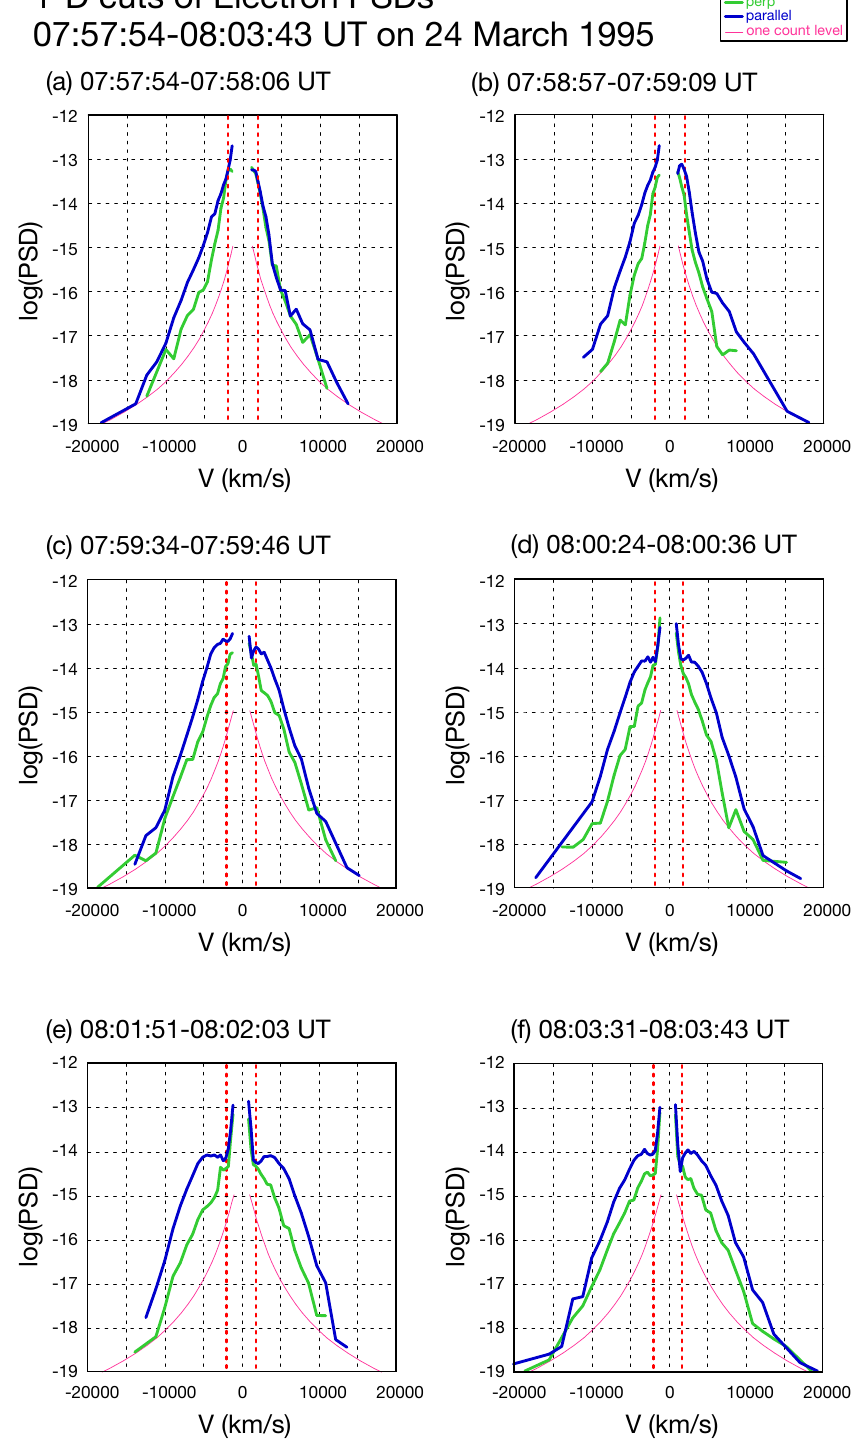
Fig. 8. 1-D cuts of the electron velocity distribution function for the boundary crossing. Each panel (a–f) corresponds to each in Fig. 7. The PSDs in the perpendicular (blue) and parallel (green) directions to the local magnetic field are presented. Red curves show the one-count level of the detector, and the PSDs within a couple of red vertical lines may contain high contributions of the